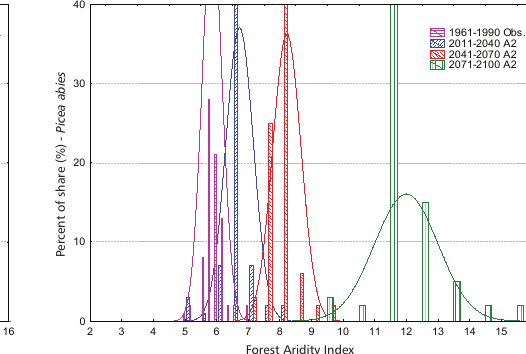
FIGURE 9. Distribution of Norway spruce across FAI categories in four climate periods